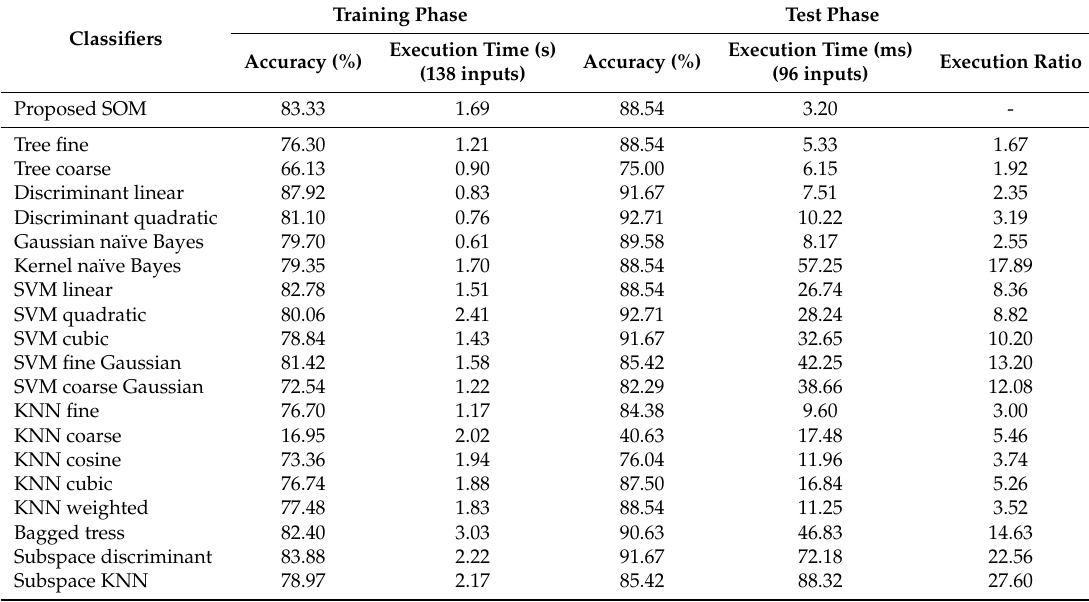
Table 6. Comparative ratios with other